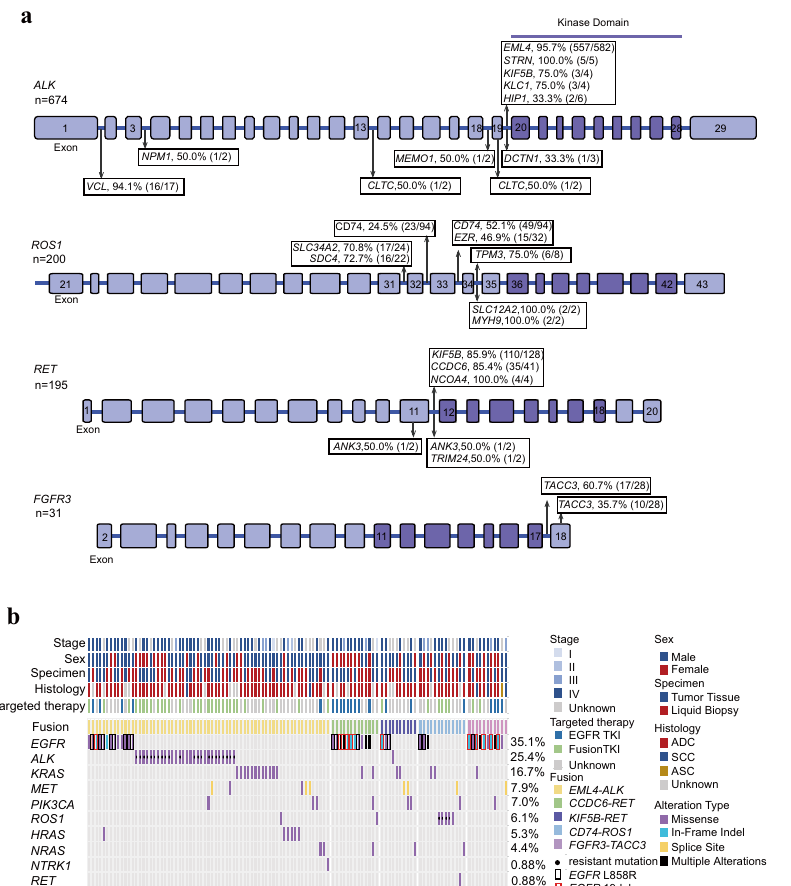
Fig. 3 The breakpoint locations for kinase genes and druggable driver mutations co-occurring with kinase fusions. a The breakpoints for ALK with different partners; the breakpoints for ROS1 with different partners; the breakpoints for RET with different partners; the breakpoints for FGFR3 with different partners. The partners shown above the structure of each kinase belong to common partners. Some rare partners are shown under the kinase structure. The number of events involving each of the four kinases is shown to the left of each kinase structures. The percentage breakpoints with each partner, the number of events for each fusion in speci fi c kinase breakpoints, and the total number of events for each fusion are shown. b The co-occurrence of kinase fusions and driver mutations is displayed in the hotspot plot. The incidences of driver gene mutations are shown to the left of the plot. Tissue/plasma samples were collected from 59 patients after developing resistance to EGFR TKI or fusion targeted treatment.